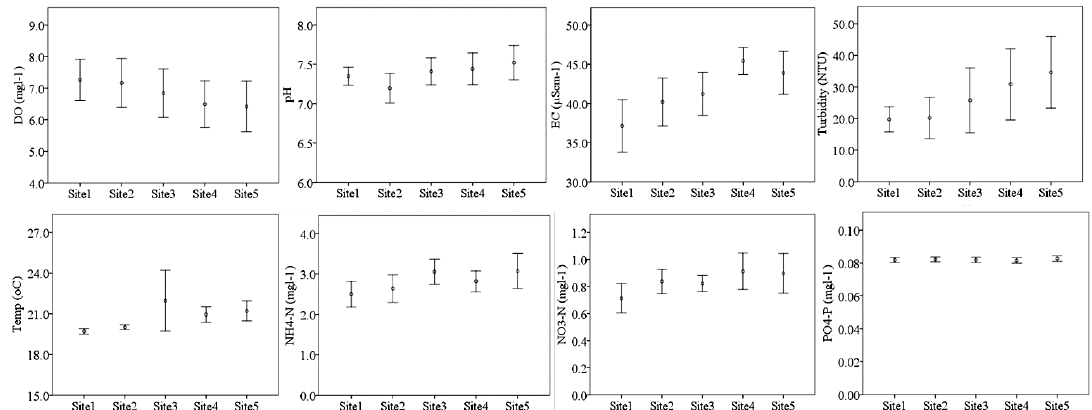
Figure 3. Physical-chemical parameters (mean ±SE), dissolved oxygen (DO), pH, electrical conductivity (EC), turbidity, temperature, ammonium-N, nitrate-N, and phosphate-P of water quality measured at different sampling sites in Kilombero Valley, where Site 1 and 2 are upstream sites, Site 3- middle site, and Sites 4 and 5 are downstream sites.